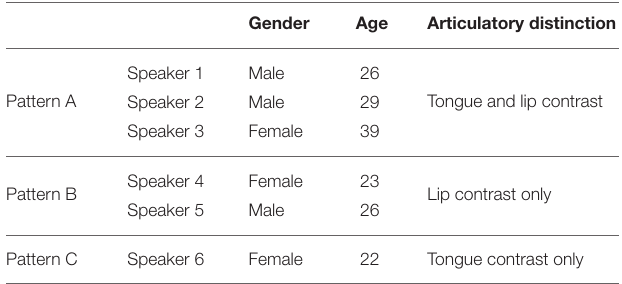
TABLE 1 | Summary of articulatory patterns observed in Experiment 1. Gender Age Articulatory